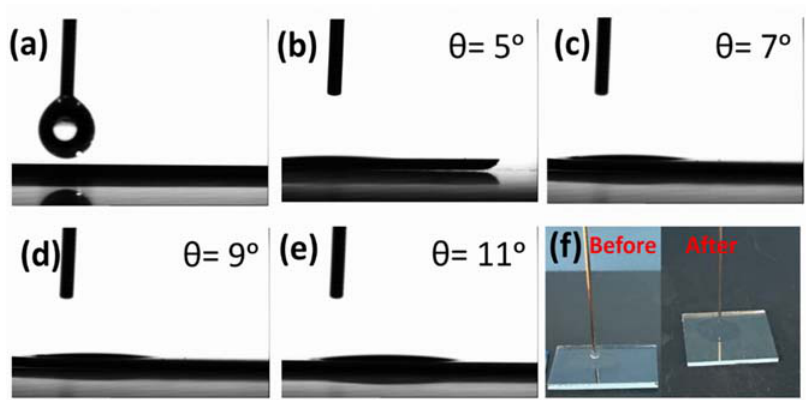
Figure 9. Contact angle measurement of SiO 2 AR coating on BK7 substrate ( a ) showing droplet volume of 5 μ L use to measure contact angle, ( b ) nanozigzag, ( c ) C ‐ shape, ( d ) nanohelix, ( e ) slanting nanostructure, and ( f ) represents the droplet spreading behavior before and after droplet removal from needle.